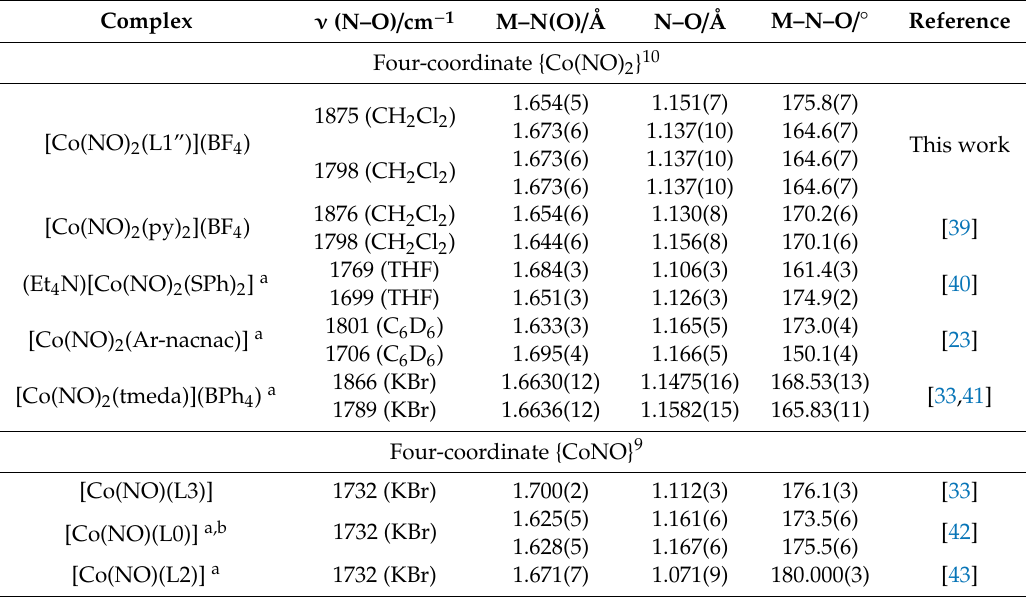
Table 2. Structural parameters of selected {Co(NO) 2 } 10 dinitrosyl cobalt complexes and the related {CoNO} 9